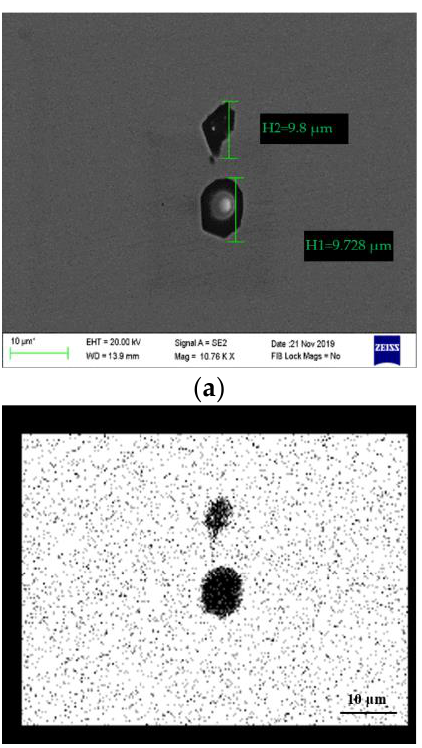
Figure 3. EDS mapping of typical Al 2 O 3 inclusion in experimental P91 steel; ( a ) SEM image; ( b ) Al; ( c ) O; ( d ) Fe.